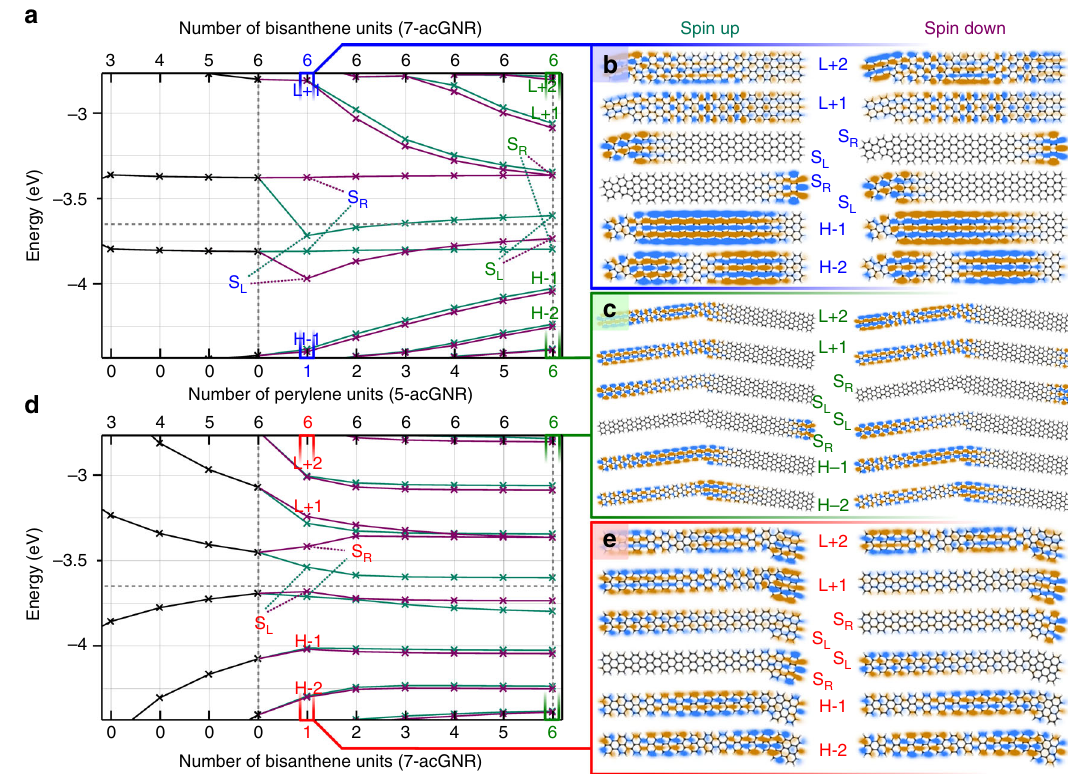
Fig. 2 Electronic structure of 5/7-GNR heterojunctions calculated by DFT. a Evolution of the energy levels of pure 7-GNR as a function of length ( left of the vertical dotted line ), and of 5/7-GNR as a function of the number of 5-GNR monomers connected to a 7-GNR 6-mer. b , c Orbital plots of the six frontier molecular orbitals of the b 5/7-GNR(1,6) and c 5/7-GNR(6,6). “ H ” denotes the highest occupied molecular orbital (HOMO), “ L ” denotes the lowest unoccupied molecular orbital (LUMO), and “ S (L/R) ” denotes a singly occupied molecular orbital localized on the left/right side (SOMO). c Same as b but for 5/7-GNR(6,6). Abbreviations as in b . d Evolution of the energy levels of pure 5-GNR ( left of the vertical dotted line ) as a function of length, and of 5/7-GNR as a function of the number of 7-GNR monomers connected to a 5-GNR 6-mer. e Orbital plots of the six frontier molecular orbitals of the 5/7-GNR(6,1). Abbreviations as in